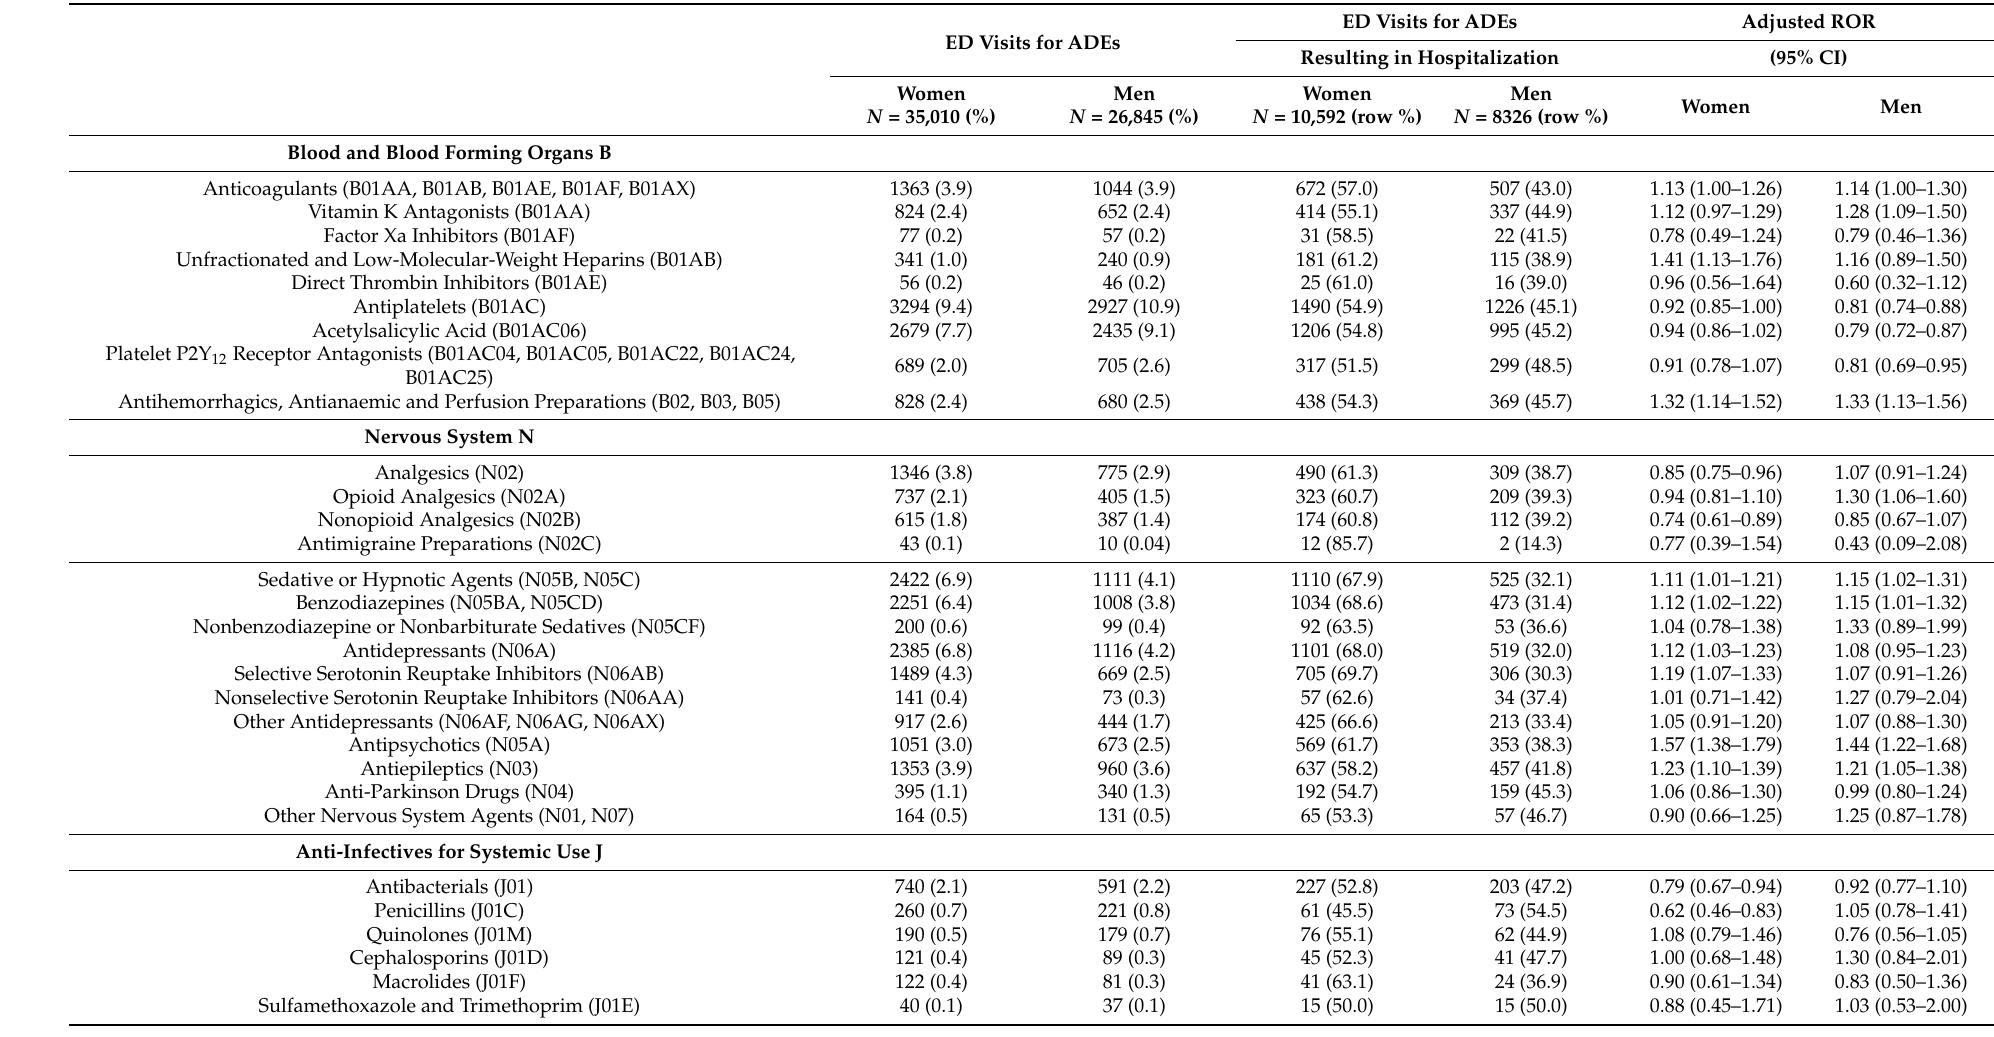
Table 2. Suspected drug classes and risk of